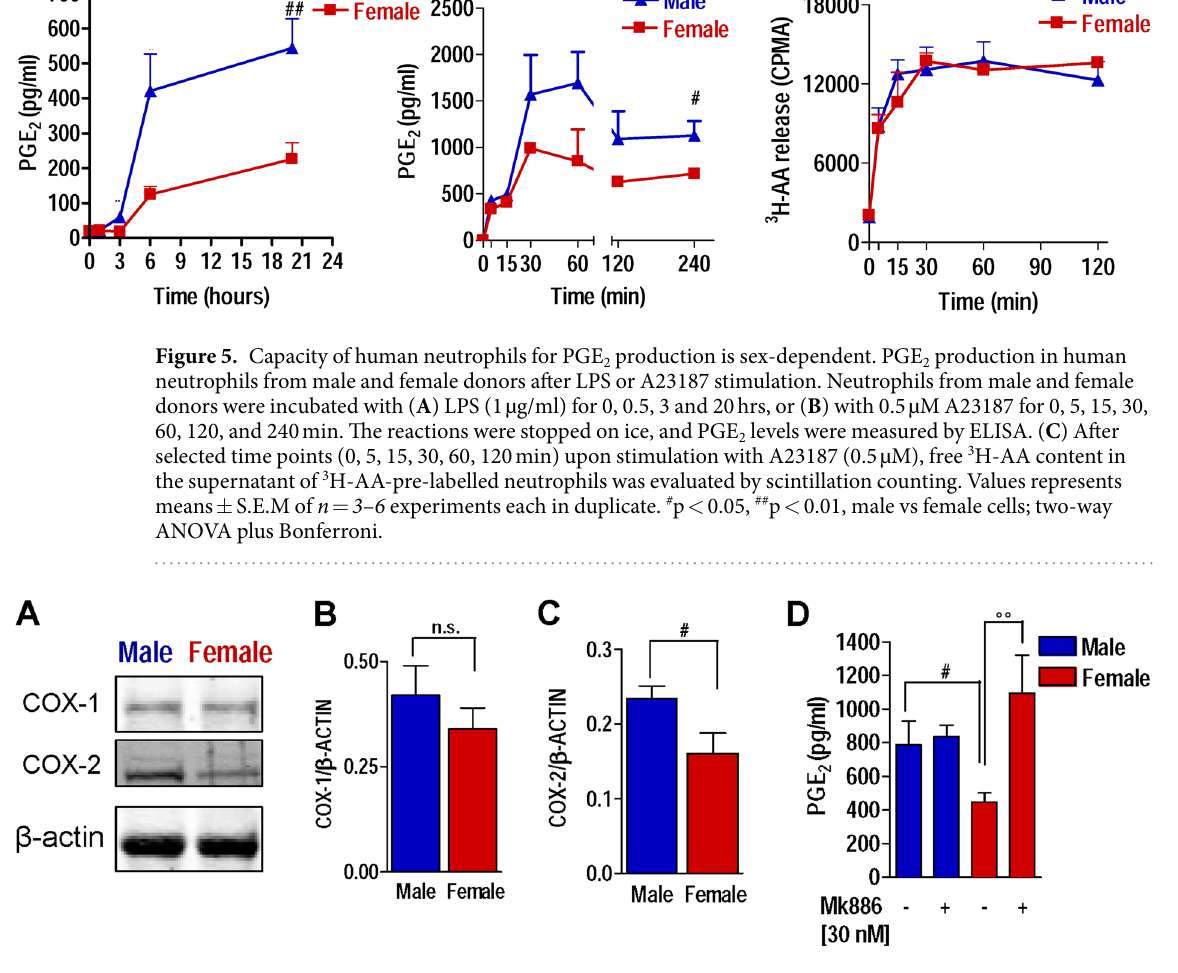
Figure 6. COX-2 expression is higher in neutrophils from male versus female donors; effects of 5-LO pathway inhibition on PGE 2 production. ( A – C ) Western blot analysis of total cell lysates of neutrophils from male and female donors. ( A ) COX-1 and -2 protein expression. Densitometric analysis of ( B ) COX-1 and ( C ) COX-2 protein normalized to β -actin expression. Western blots are representatives of 11 independent experiments. Values represents means ± S.E.M of densitometric analyses of COX-1/-2 protein bands, normalized to β -actin. # p < 0.05, male vs female cells. ( D ) PGE 2 production in human neutrophils from male and female donors after pre-treatment with MK886 (30 nM, 15 min) upon A23187 stimulation (0.5 µ M, 4 hrs). Values represents means ± S.E.M of n = 5 experiments, each in duplicate. # p < 0.05, male vs female; °° p < 0.01, female cells with MK886 vs female control cells; two-tailed Student’s t